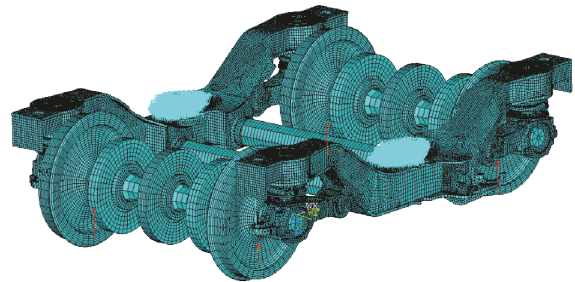
Figure 4: FEM of the whole bogie